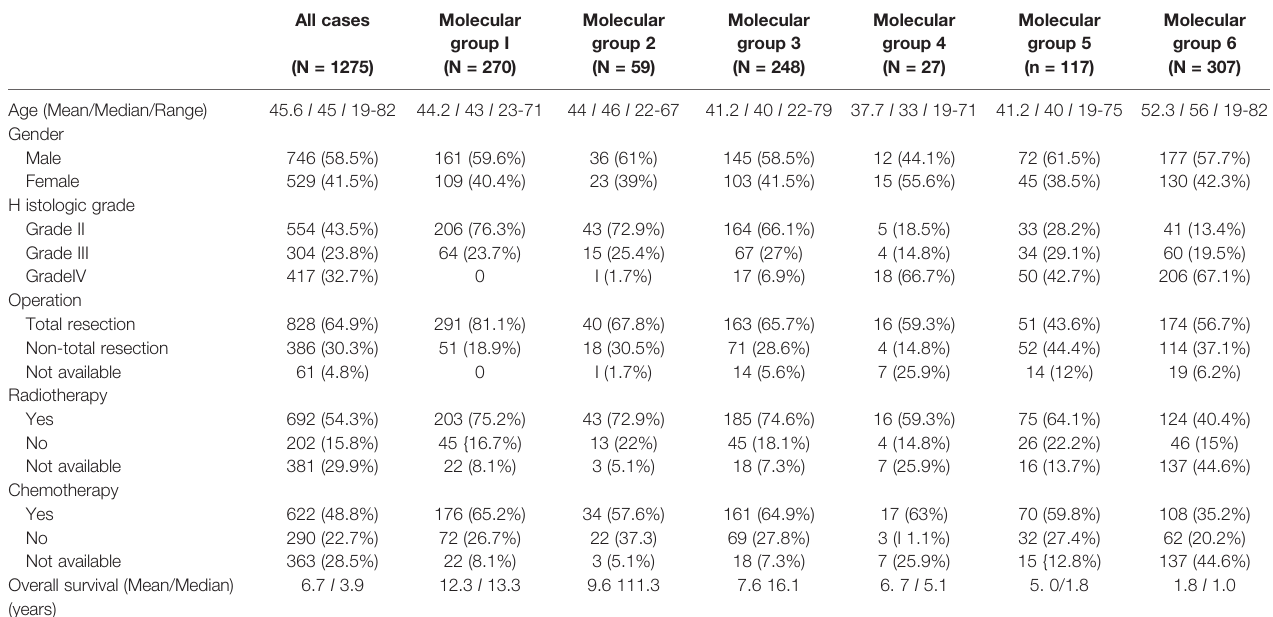
TABLE 1 | Clinical characteristics of 1,275 diffuse